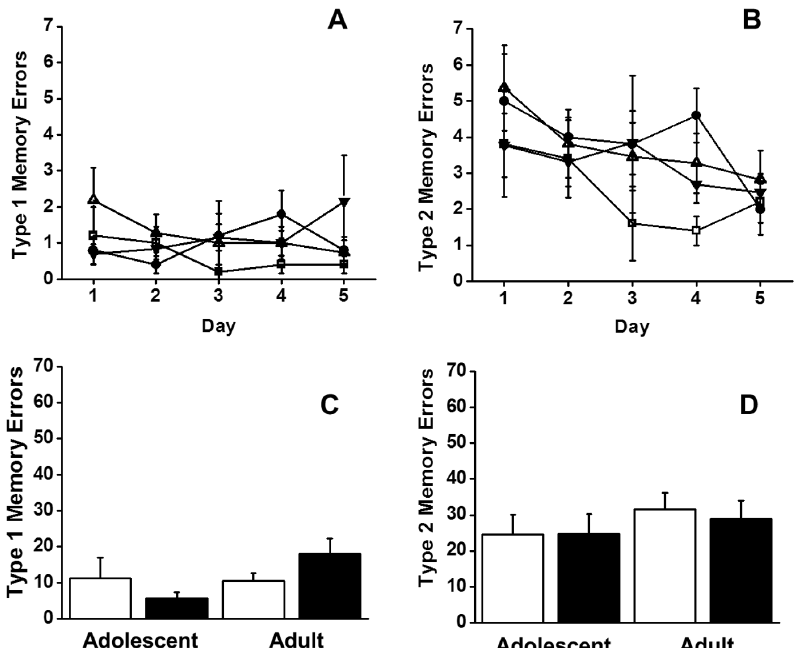
N Figure 2. Effects of chronic intermittent ethanol ( and . ) or saline ( % and n ) exposure during adolescence or adulthood (respectively), on type1 working memory (panel A) and type2 working memory (panel B) errors over the 1st 5 days of training in the DNMTP. The histograms represent the cumulative effect of ethanol (black bars) and saline (white bars) on type1 (panel C) and type2 (panel D) working memory errors. Data are expressed as means 6 SEM (n=5 adolescent saline, n=5 adolescent CIE, n=5 young-adult saline, n=7 young adult CIE, n=6 adult saline, n=6 adult CIE).